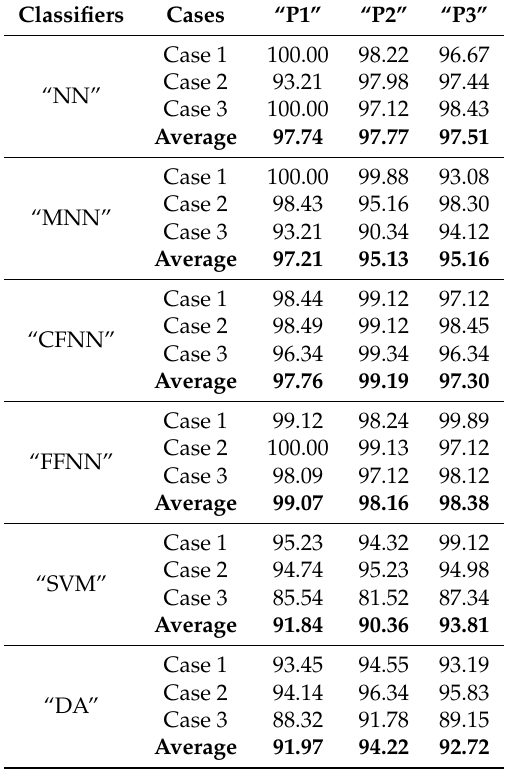
Table 5. Classification accuracies (%) obtained with different cases by employing dataset